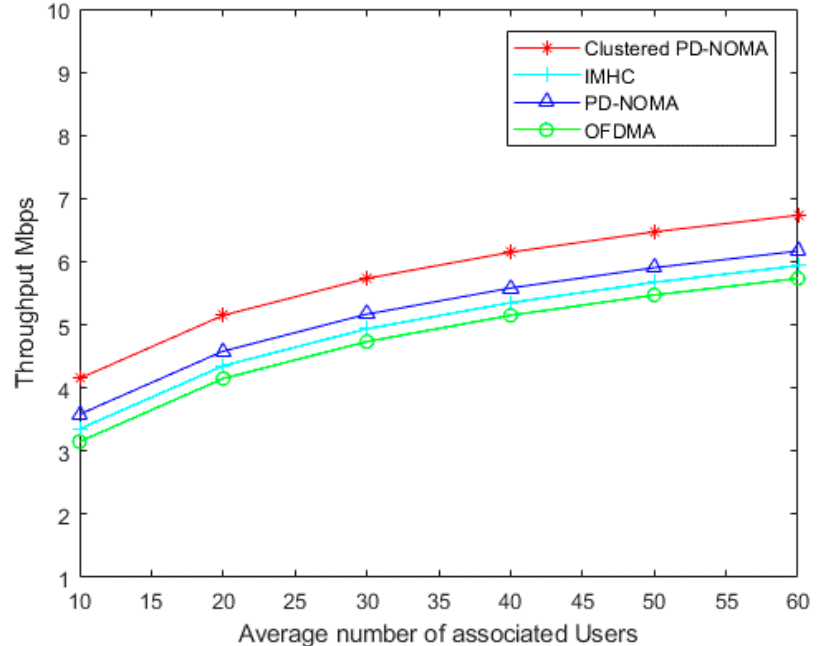
Figure 8. Comparative analysis of throughput gain achieved with the proposed scheme and the existing schemes.